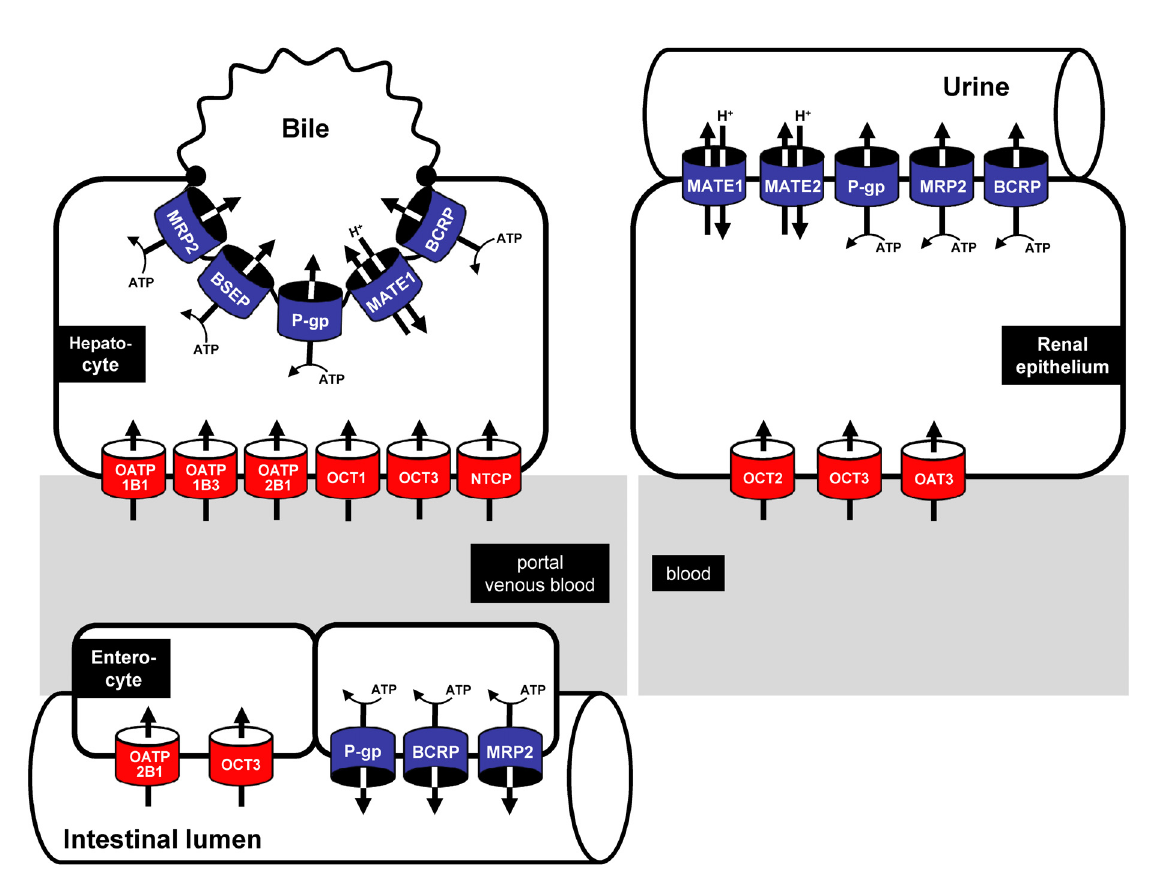
Figure 1. Uptake and export transporters involved in the intestinal absorption (enterocyte) and the hepatic (hepatocyte) and renal (renal epithelium) excretion of oral antidiabetic drugs. Uptake transporters (red): OATP = members of the organic anion transporting polypeptide family; OCT = members of the organic cation transporters; export transporters (blue): MRP2 = multidrug resistance protein 2; BSEP = bile salt export pump; BCRP = breast cancer resistance protein; P-gp = P-glycoprotein; MATE = members of the multidrug and toxin extrusion protein